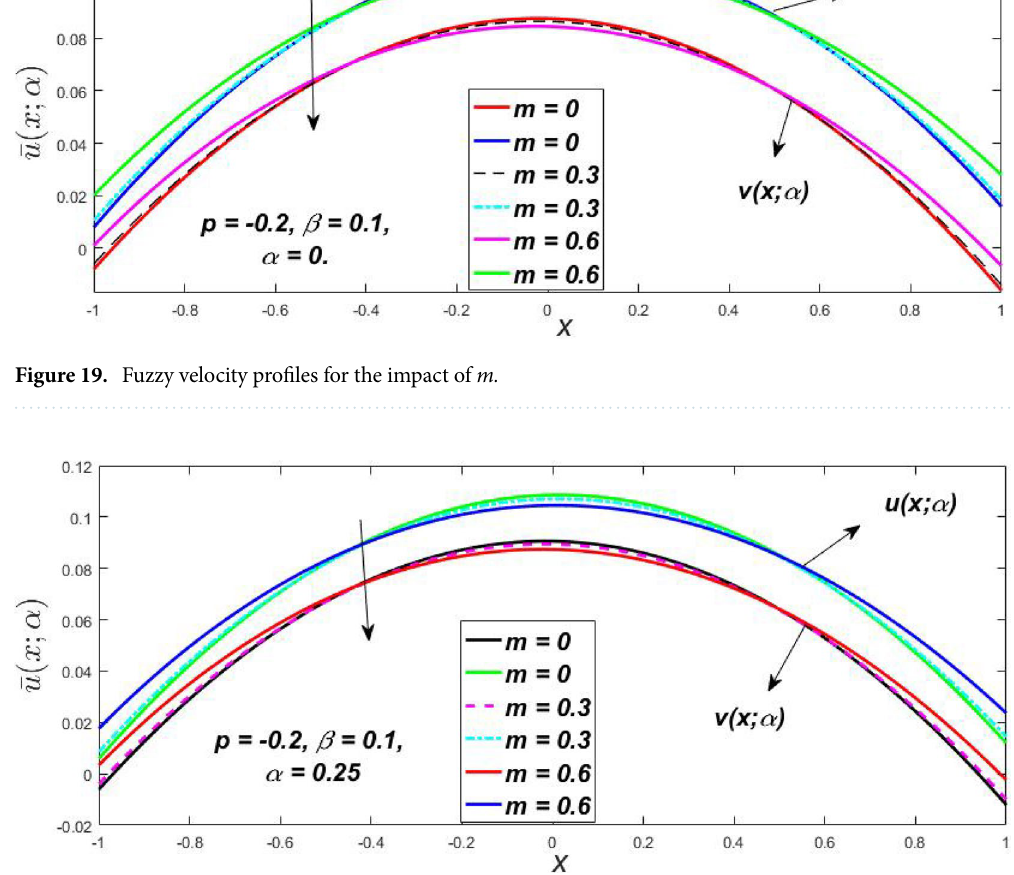
Figure 20. Fuzzy velocity profiles for the impact of m.